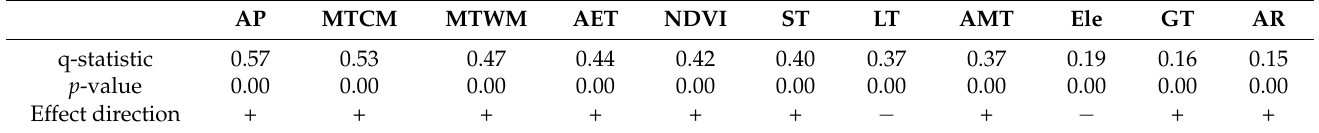
Table 1. Association of each environmental factor with species richness (q values).